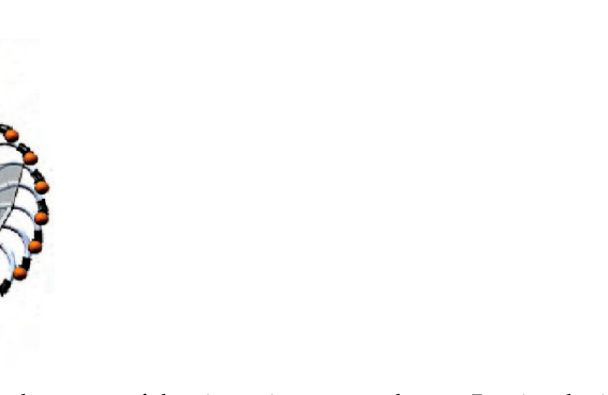
Figure 25. Grimme GB 430 potato planter. ( a ) Trailed furrow openers of GB430. Reprinted with permission from ref. [89] Copyright 2022 Grimme Industries; ( b ) Structure for lighter soils. Re- printed with permission from ref. [89] Copyright 2022 Grimme Industries; ( c ) Structure for heavy soils. Reprinted with permission from ref. [89] Copyright 2022 Grimme Industries. Dewulf Miedema CP 42 planters [72] (Figure 26) are equipped with an intelligent floating control system, which can monitor the depth of the seed trench timely and auto- matically adjusts the soil tillage depth through sensors during the seeding process so as to automatically maintain a certain tillage depth while ensuring sufficient seeding precision.